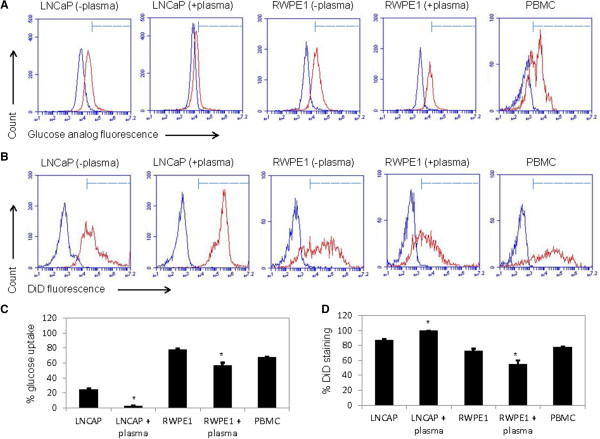
Comparison of glucose and lipid uptake between RWPE1, LNCaP and PBMC. (A) Glucose and (B) lipid uptake of LNCaP, RWPE1 and PBMC cells. Blue lines represent control cells without incubation with neither fluorescent glucose analog nor DiD. Red lines represent cells incubated with either fluorescent glucose analog (A) or DiD (B). Dashed lines with bar heads indicate the cut-off fluorescence intensity values that separate stained cells from unstained cells. Cut-off values were chosen to exclude >95% of control unstained cells. Cells were incubated with plasma for 16 hours, then with fluorescent glucose analog or with lipophilic DiD dye for 15 minutes. Data presented are of one set of flow cytometry experiment. (C) and (D) are graphical presentation of average flow cytometry data of at least 4 repeats per experimental condition for glucose and lipid uptake, respectively. Error bars are standard deviation across 4 repeated measurements. Asterisk indicates P-value < 0.05 determined with paired Student’s t-test against untreated control.